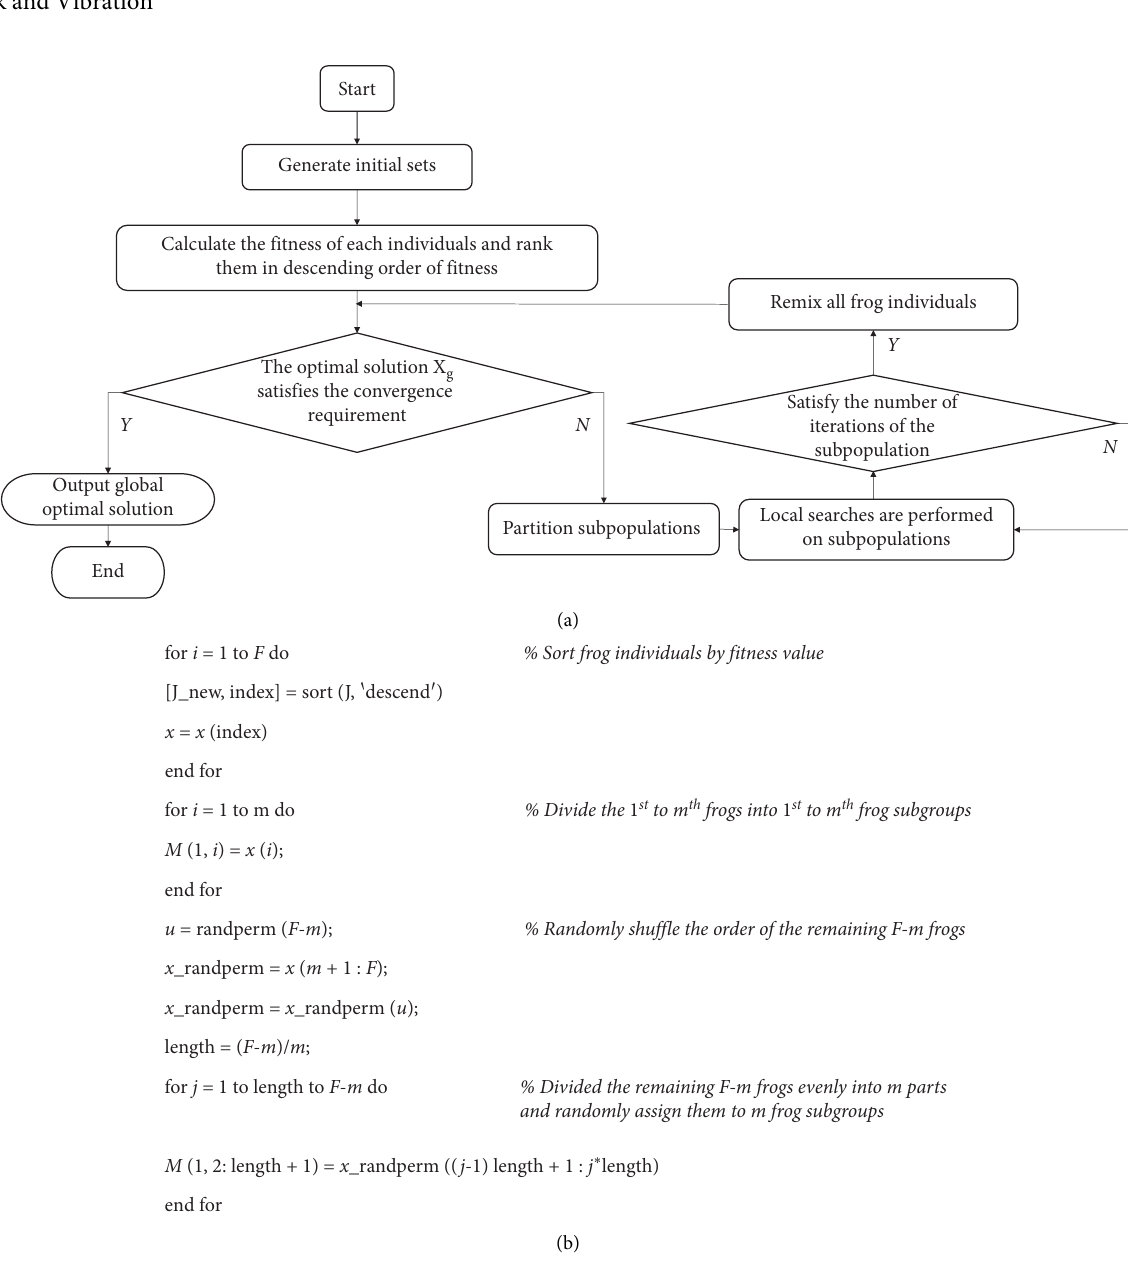
Figure 11: The algorithm process of SFLA. (a) The flowchart of SFLA. (b) Algorithm steps.